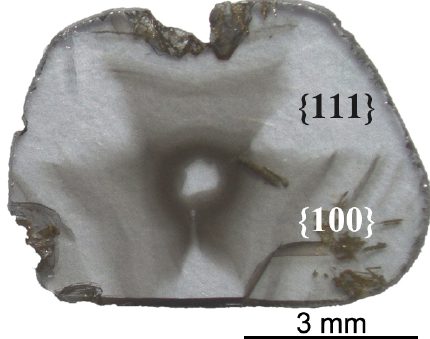
Figure 1. The Zimbabwean mixed-habit diamond section, NDS- 2, cut off along {111} planes of the diamond crystal. The brown regions with dense inclusions are cuboid growth sectors, and the inclusion-free colorless regions are octahedral growth